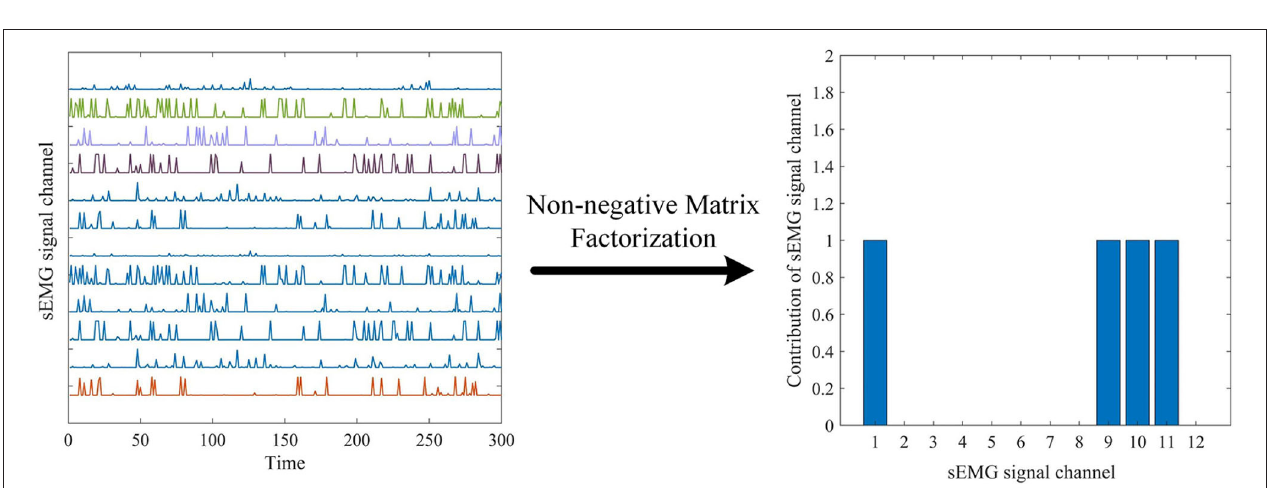
FIGURE 6 | The average output of all surface electromyography (sEMG) signal samples about the sitting movement for subject 7, and non-negative matrix factorization method id used to find the synergy channels.